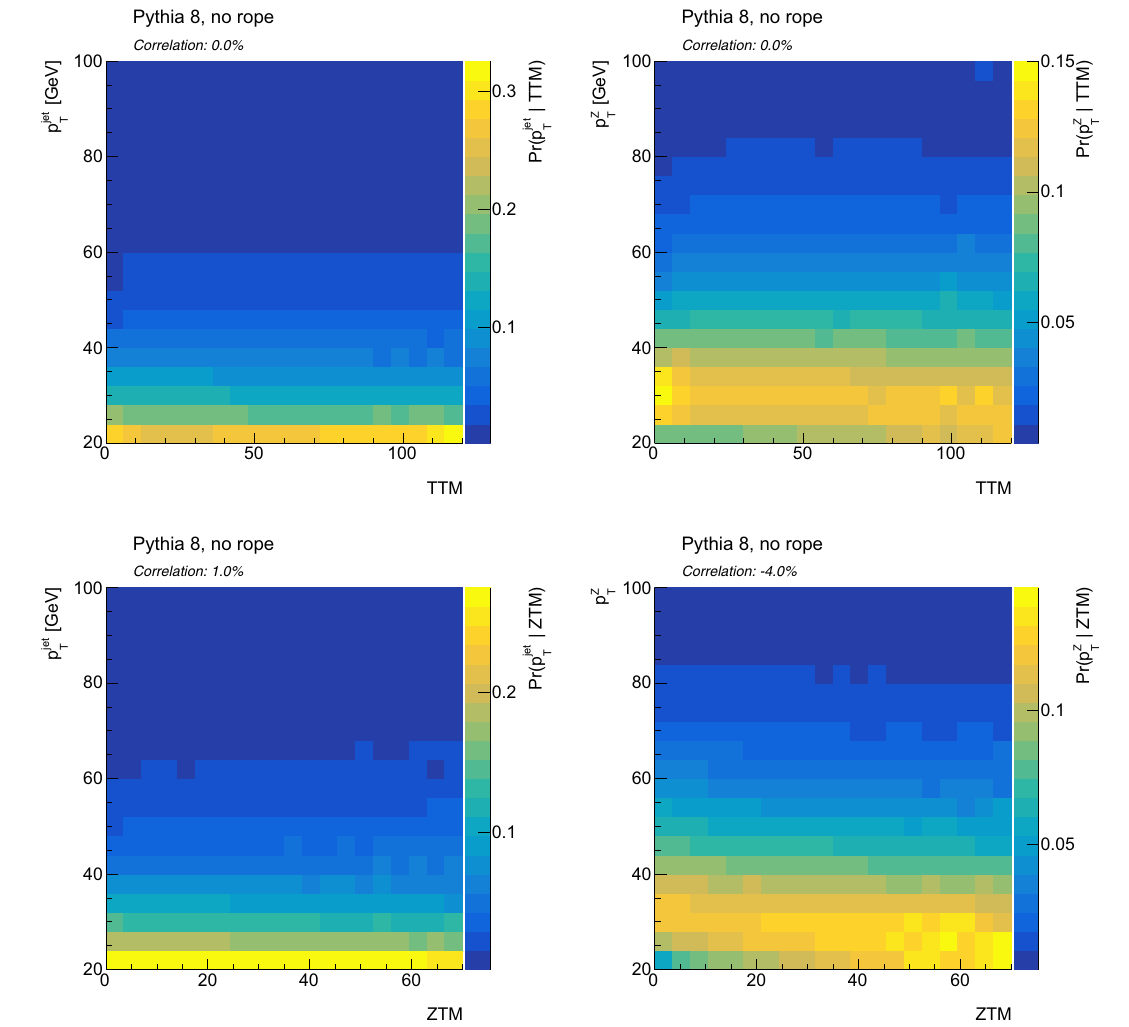
Fig. 17 The distribution of the jet (left) or Z boson (right) p T given the event multiplicity defined by TTM (top) and ZTM (bottom). The linear correlation coefficient is presented at the top of each